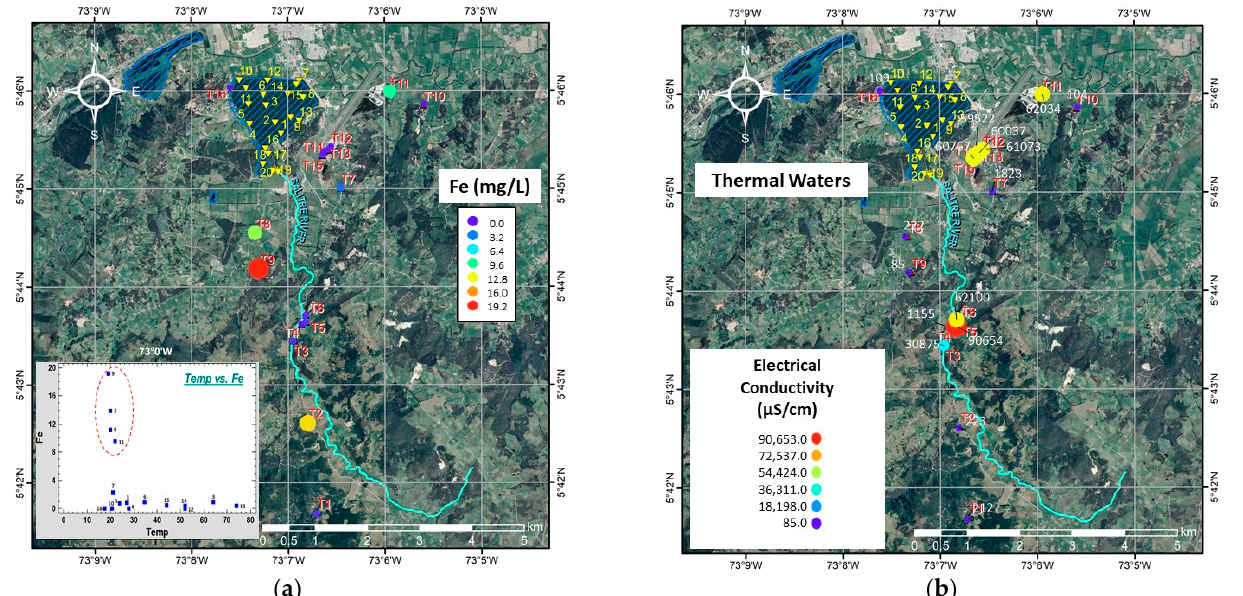
Figure 8. ( a ) Map of Fe content in the Paipa area and the relationship of Fe concentration vs. temperature in the left corner. ( b ) Map of electrical conductivity in this area. In both plots, a color and size scale are used: reddish-warm colors and big dots are related to high values.